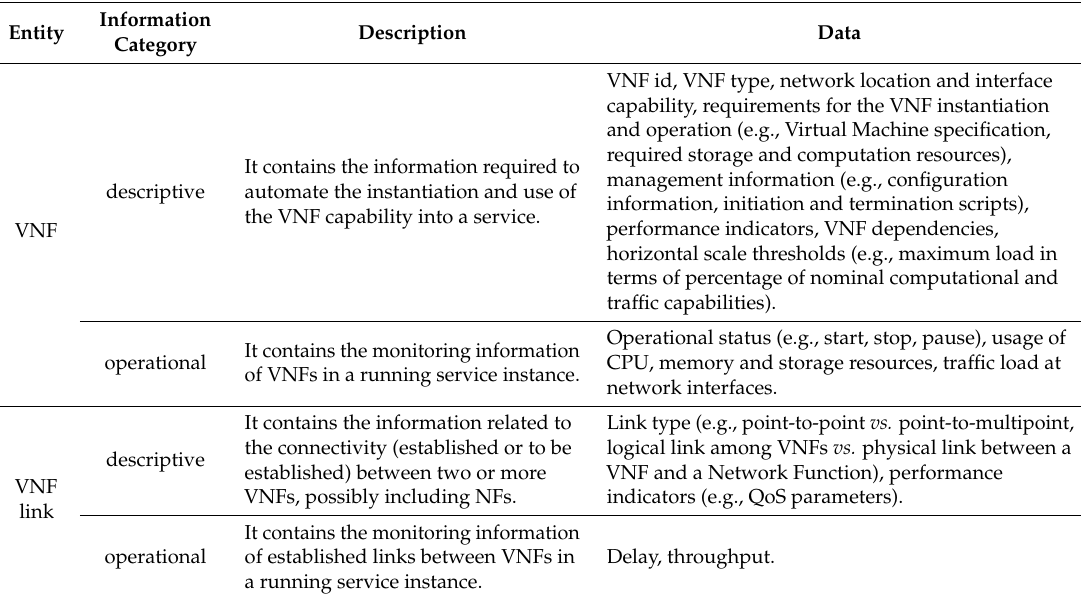
Table 1. Network Function Virtualization data